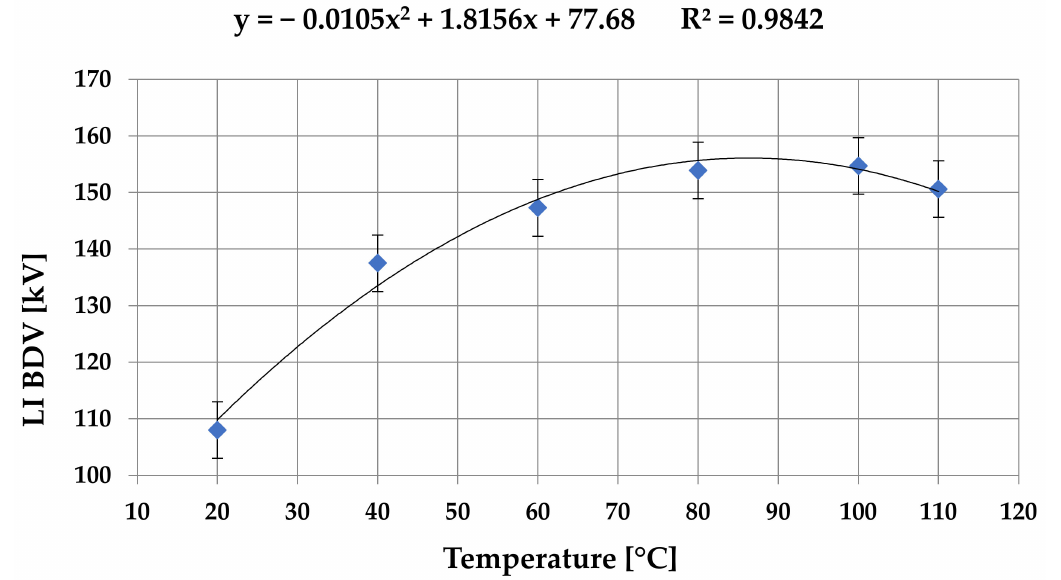
Figure 5. Relationship between lightning impulse breakdown voltage and temperature. y, regression line; R 2 , correlation factor.